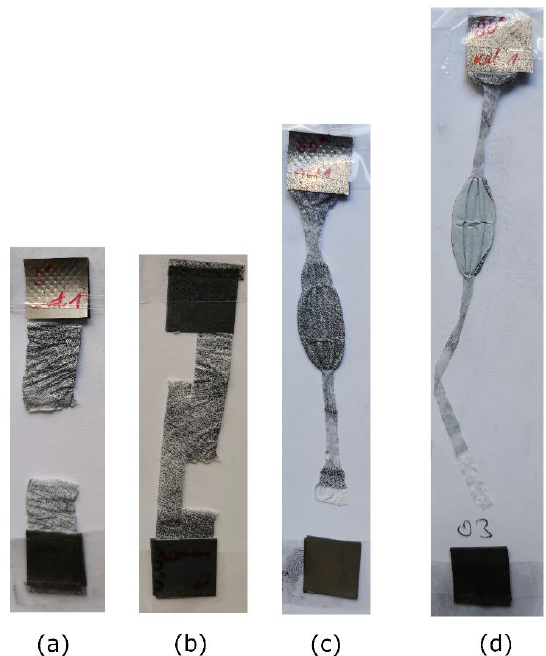
Figure 5. Examples of extreme behavior: ( a ) relatively brittle fracture in the center, representing the desired, best behavior; ( b ) failure along the specimen length; ( c ) intermediate stabilization and localization in different areas; ( d ) extreme elongation with two different localization areas in the specimen.